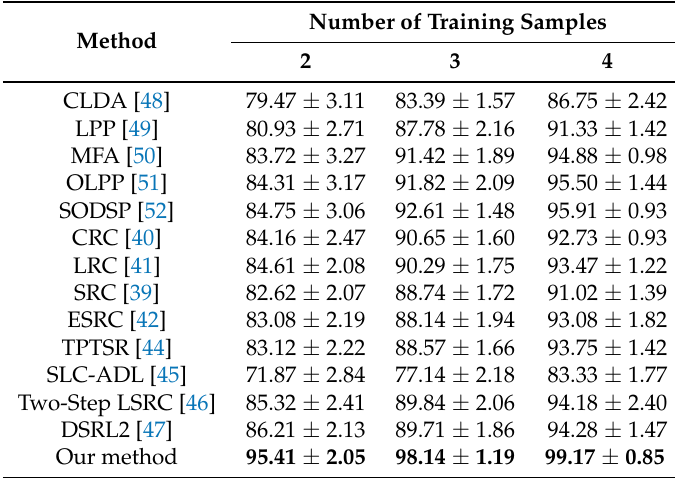
Table 1. Face recognition rates (%) of different methods on ORL